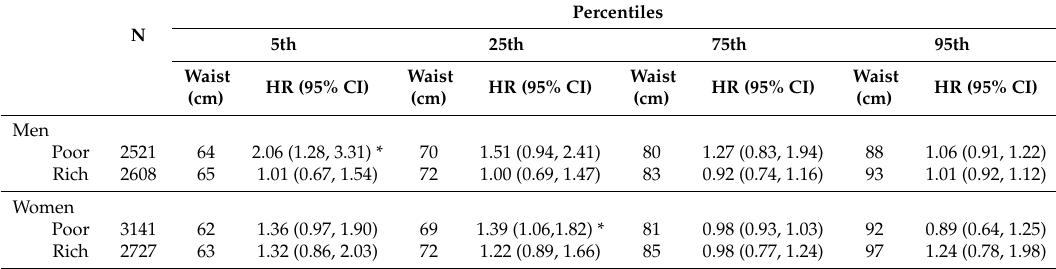
Table 3. All-cause mortality by sex and wealth status. Hazard ratio (HR) and 95% confidence intervals (CI) of covariates from multivariate adjusted Cox regression analysis with restricted cubic splines. WHO-INDEPTH SAGE Purworejo longitudinal data